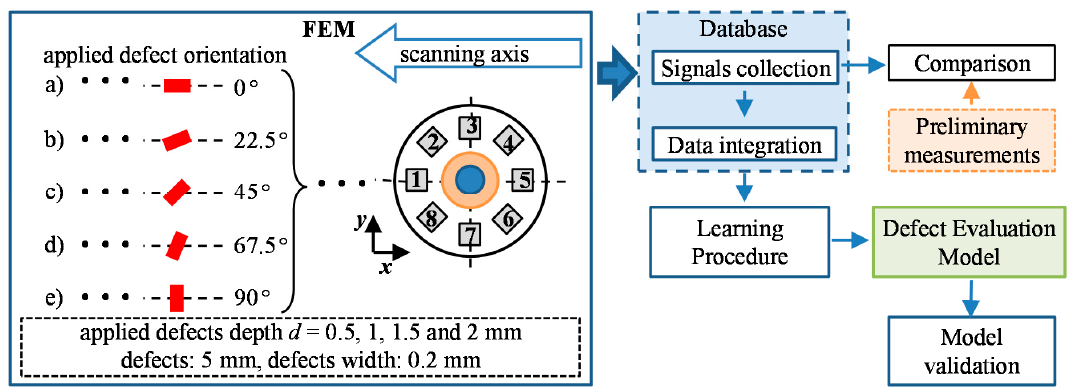
Figure 3. The schematic diagram of the definition of the defect characterization model; FEM—finite element method.